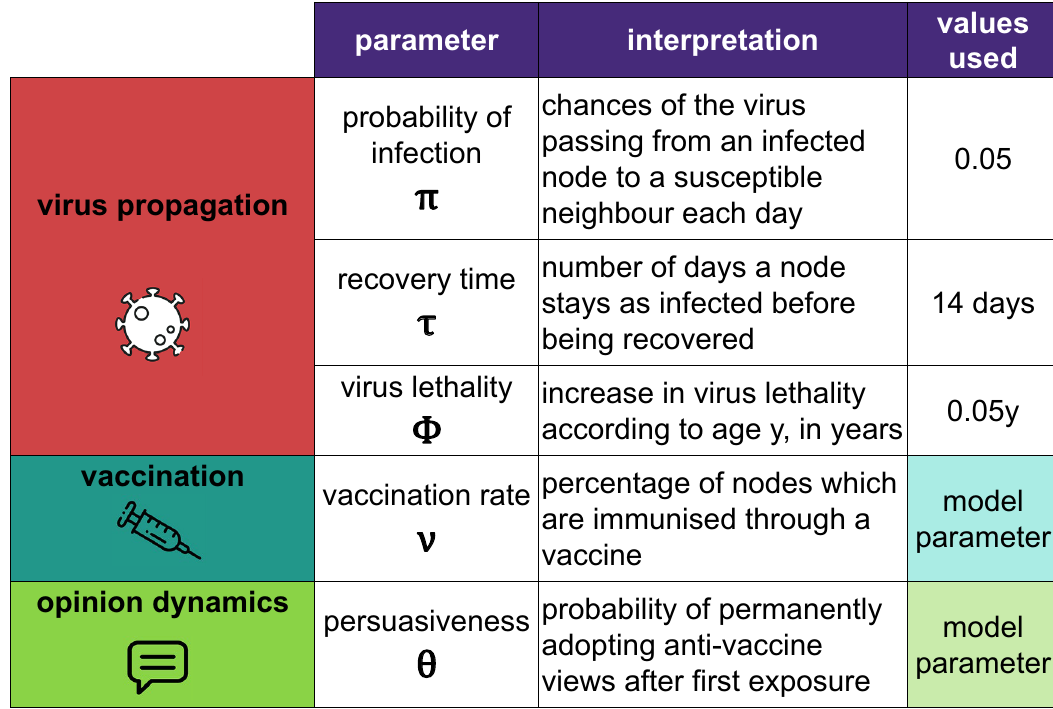
Figure 5. Main parameters used to model the propagation of some virus on a network, under some vaccination rate and strategy, where some individuals adopt anti-vaccination views. In terms of the virus, the three parameters are the probability of infection π , the recovery time τ and the lethality φ and are somehow related. The probability that a susceptible person is infected by an adjacent infected node is 1 − ( 1 − π) τ ≈ 0.51 (for the values of the parameters used) since they have interactions for a period of τ days. The model parameters, which are used to detect the impact of anti-vaccine views and to measure the results of a vaccination strategy are the vaccination rate ν and the persuasiveness of the views θ , which are considered for all of its potential values in the [ 0, 1 ]